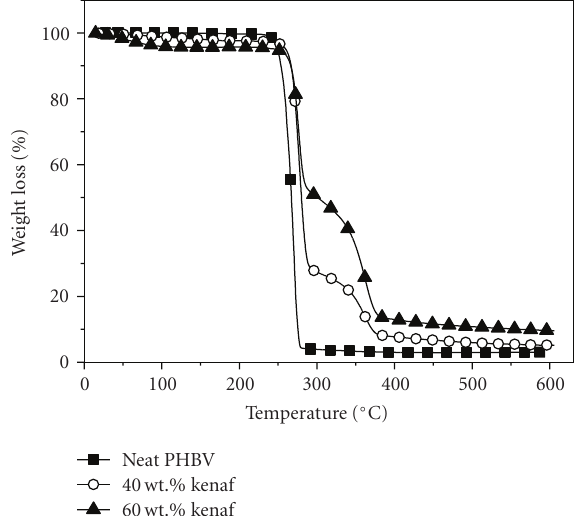
Figure 4: Thermogravimetric curves for PHBV-based systems.